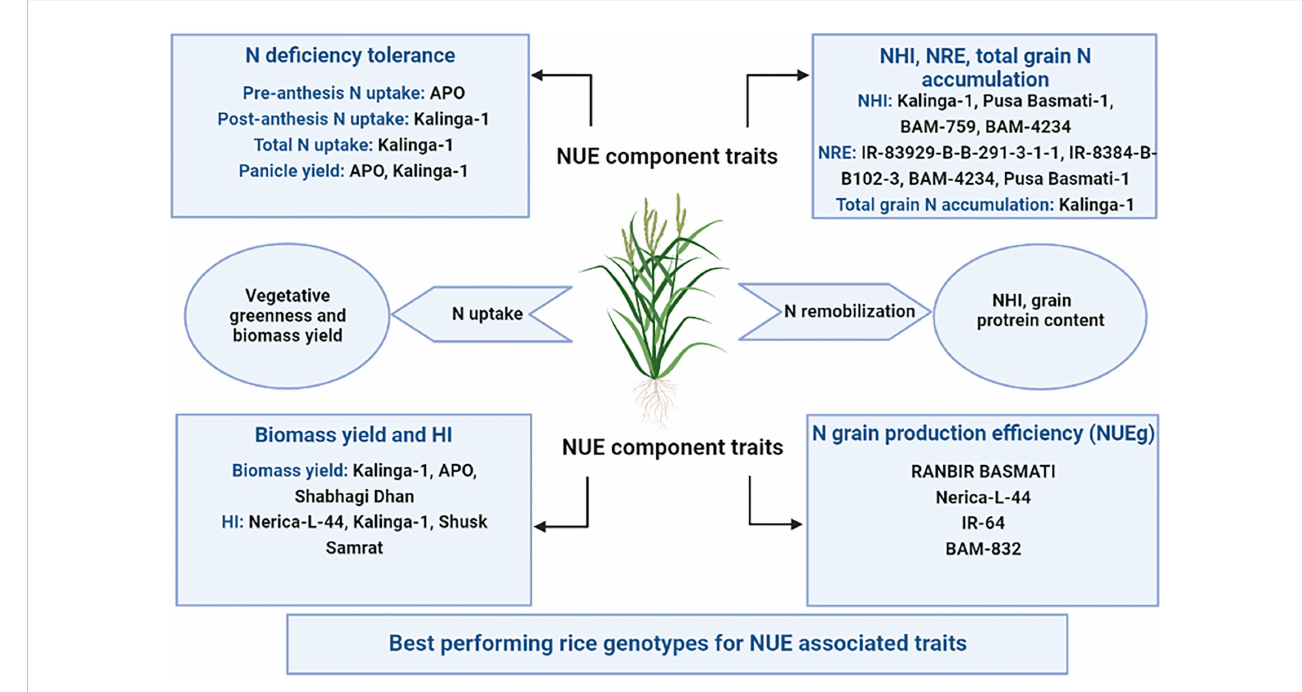
FIGURE 12 Schematic representation of N use ef fi ciency (NUE) component traits in rice and best-performing genotypes under both nitrogen de fi cient (0 kg ha -1 fertilizer N: N0) and nitrogen suf fi cient (120 kg ha -1 fertilizer N: N120) fi eld conditions. NHI, Nitrogen Harvest Index; NRE, Nitrogen Remobilization Ef fi ciency; HI, Harvest Index; and NUEg, Nitrogen grain production ef fi